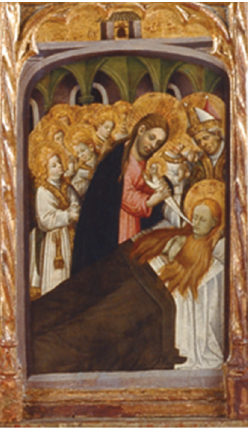
Figure 2. Bernat Martorell. “Transit of Mary Magdalene”. Detail from Altarpiece of Saint Mary Mag- dalene from Perella , 1437–1452, Episcopal Museum of Vic.